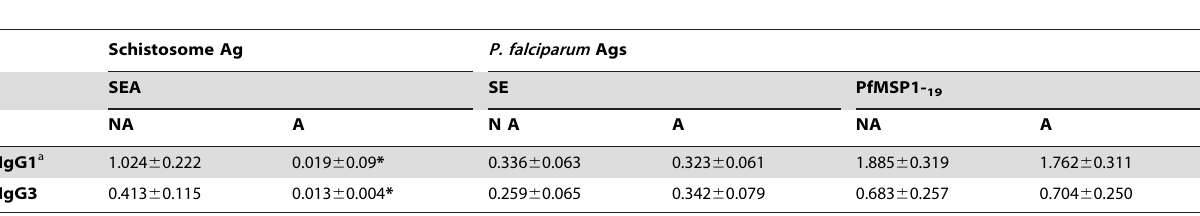
a : Results are mean 6 SEM of individual specific production (after subtracting the amount detected in unstimulated medium control cultures for each individual). Ag: Antigen.